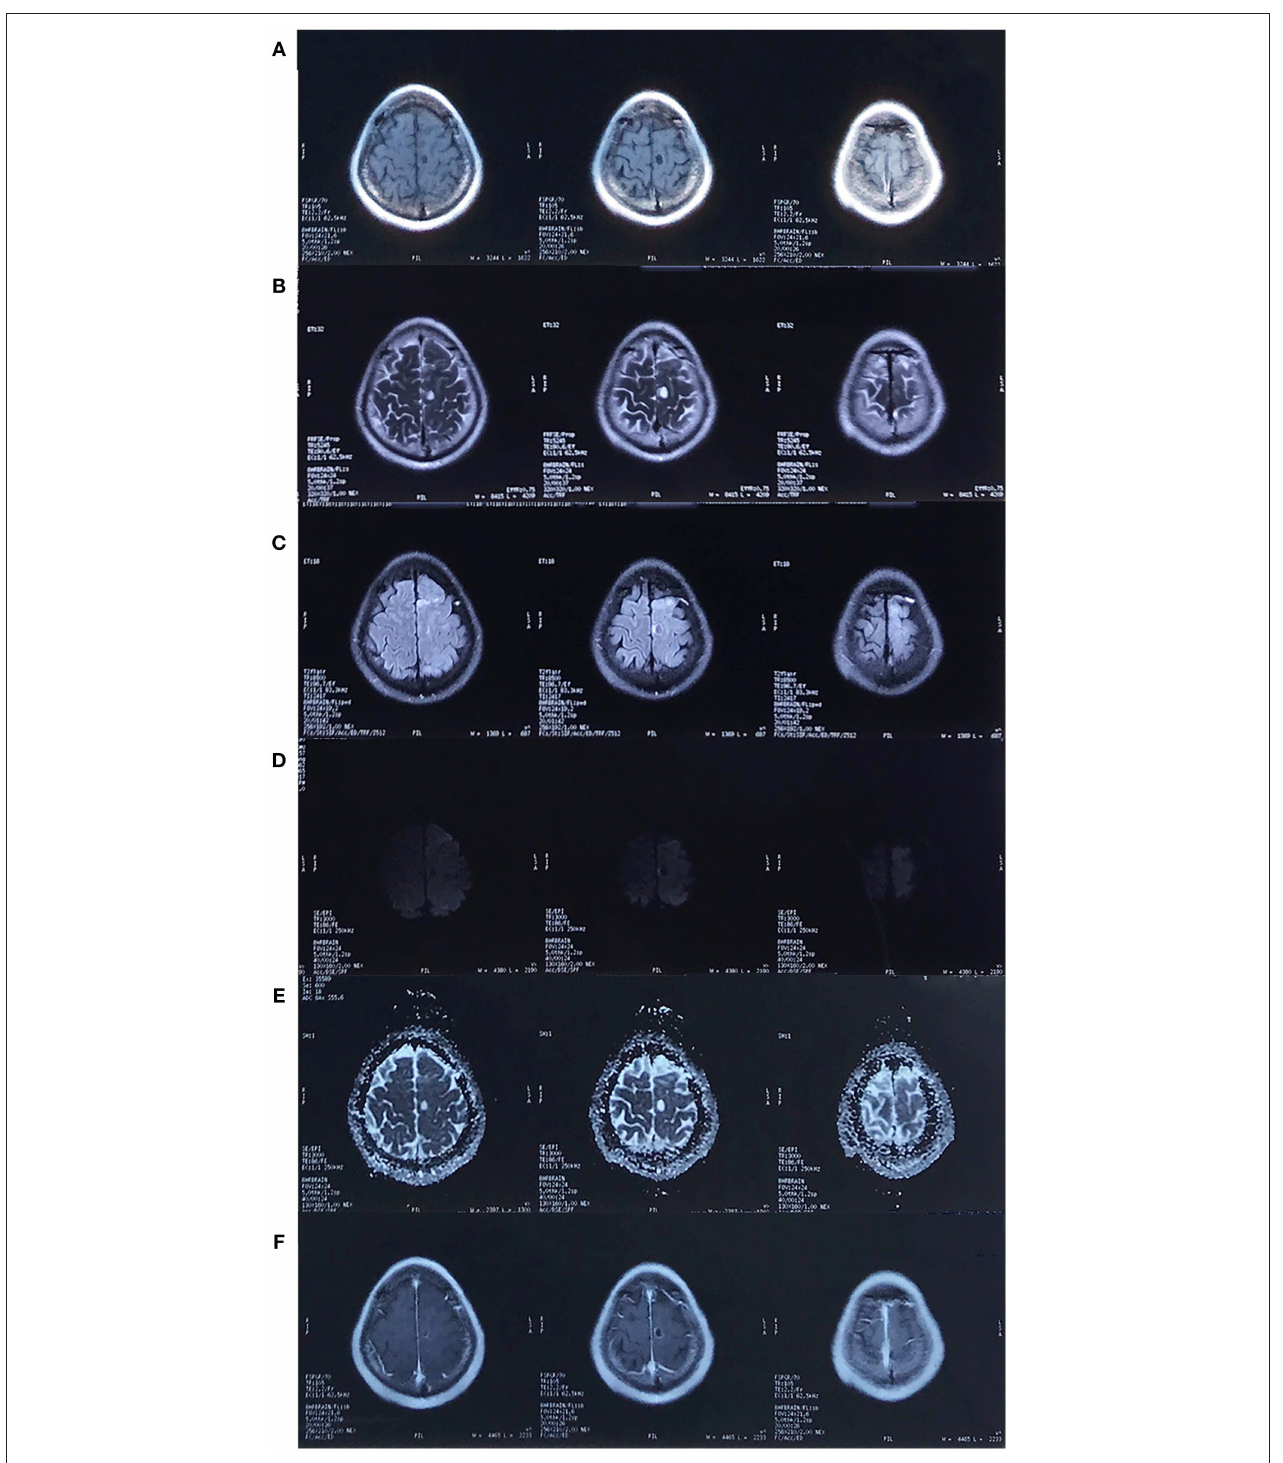
FIGURE 2 | MRI in October 2017. There was a cystic lesion in the left frontal lobe that presented as hypointense on the T1-weighted image (A) , hyperintense on the T2/T2-FLAIR/Apparent diffusion coefficient (ADC) image (B,C,E) and hypointense on the diffusion weighted imaging (DWI, D ), with surrounding edema and rim enhancement (F)